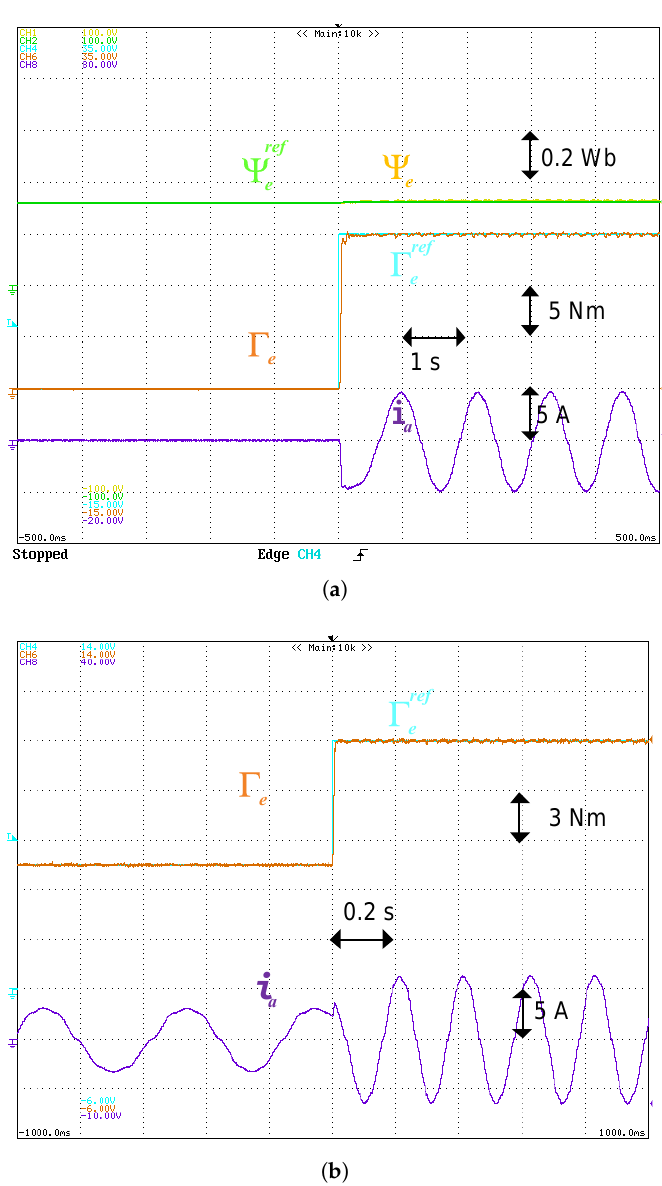
Figure 9. Experimental plots: torque tracking performance for the following tests: ( a ) start-up (0 to 15 Nm); ( b ) reference torque step (7.5 Nm to 15